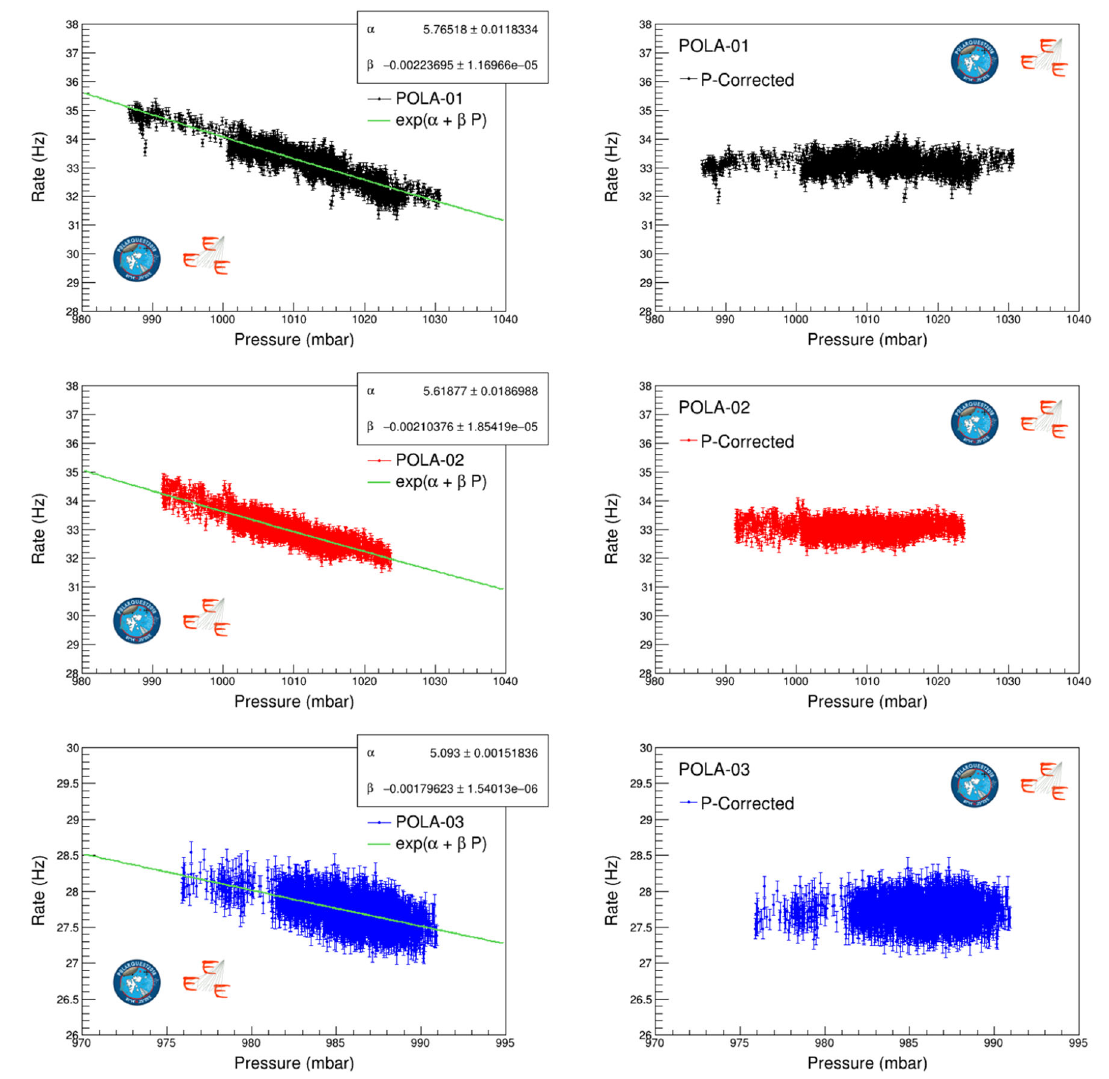
Fig. 22 POLA-01 (top), POLA-02 (middle) and POLA-03 (bottom) rates as a function of the pressure. Left column: rates corrected for the anglewithrespecttotheverticaldirectionforPOLA-01andrawratefor POLA-02 and POLA-03 (the green line shows the best fit result); right